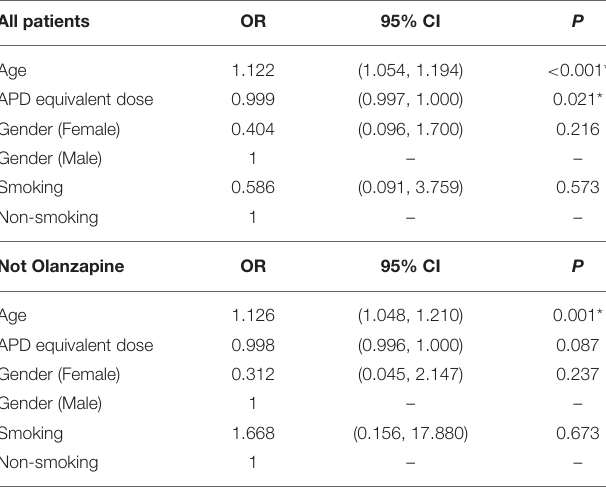
TABLE 3 | Ordinal regression analysis between AoAC grade and potential factors in patients with APD treatment or without olanzapine treatment. All